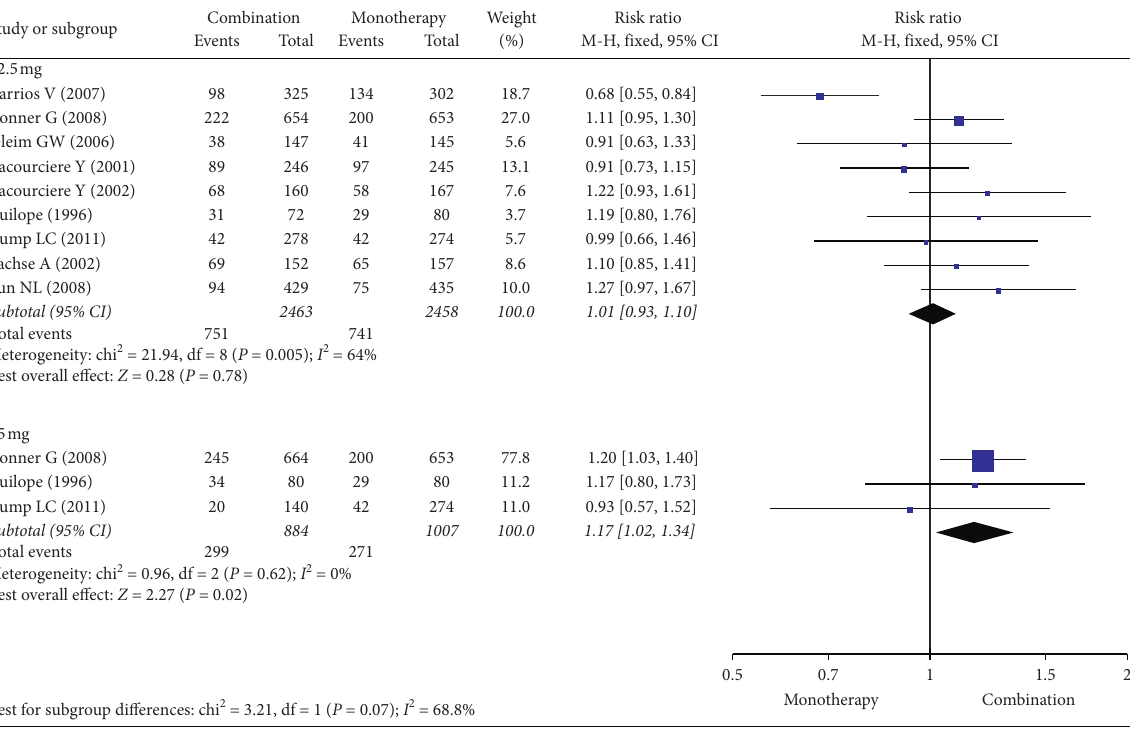
Figure 6: Forest plot for total adverse events